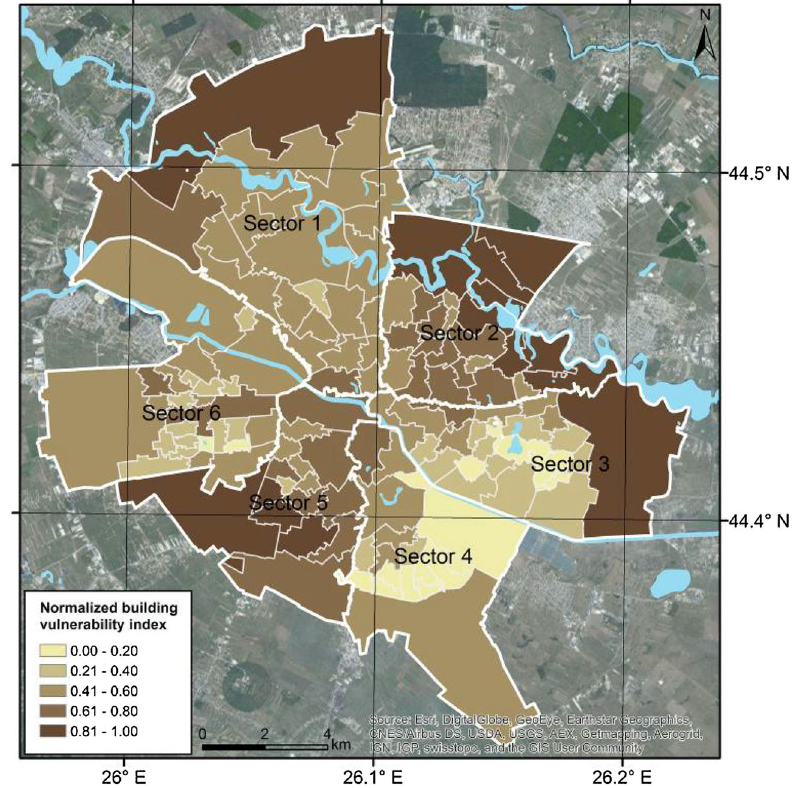
Fig. 5 Map showing the results of the vulnerability assessment for residential buildings; values are normalized between 0 and